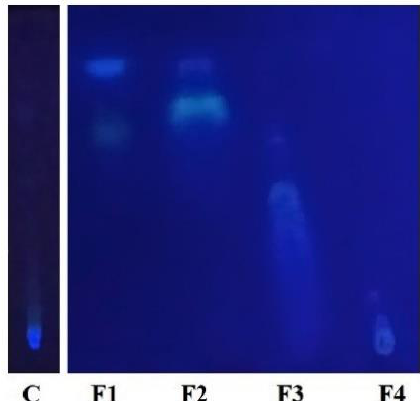
Figure 3. First TLC made with the control 1 (C) and the four fractions obtained from the fist VLC. F1 is the fraction obtained with hexane, F2 with dichloromethane, F3 with ethyl acetate and F4 with methanol.